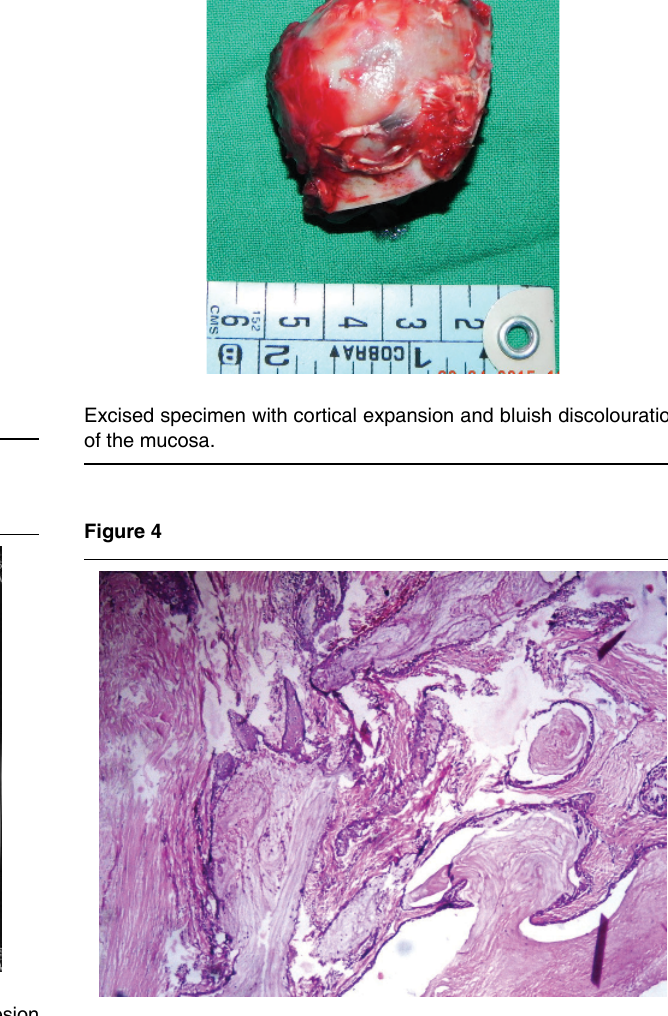
HPE× slide showing nests of neoplastic squamous cells along with mucous secreting